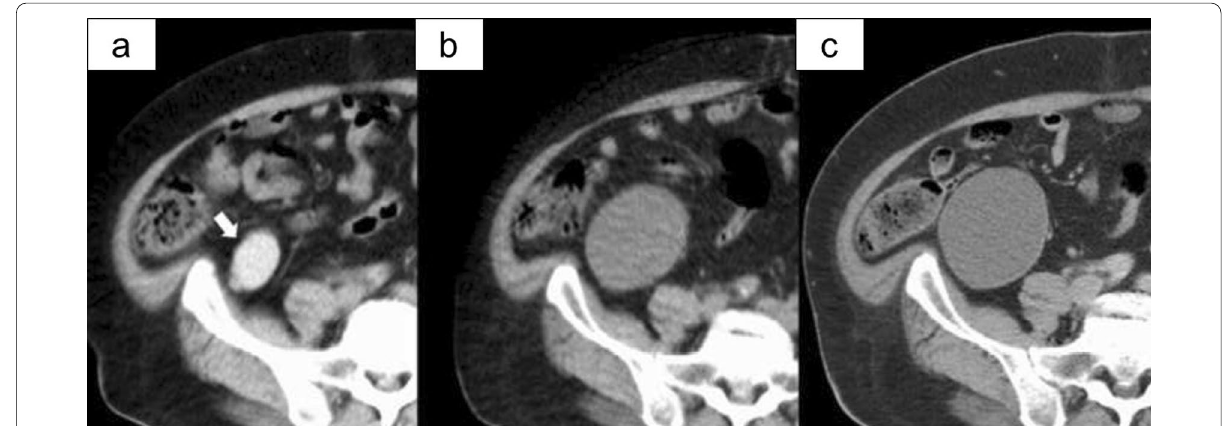
Fig. 2 Computed tomography changed over time. Non-enhanced CT performed 3 years previously showed a 5-cm cystic mass with a uniform high density (arrow) ( a ), while non-enhanced CT performed 6 months previously showed a cystic mass had grown to 8 cm with a uniform low density ( b ). On the most recent CT scans, the concentration in the cyst was slightly reduced in comparison to these images (CT value: 20.3HU), and the diameter of the cyst had grown to 10 cm ( c )